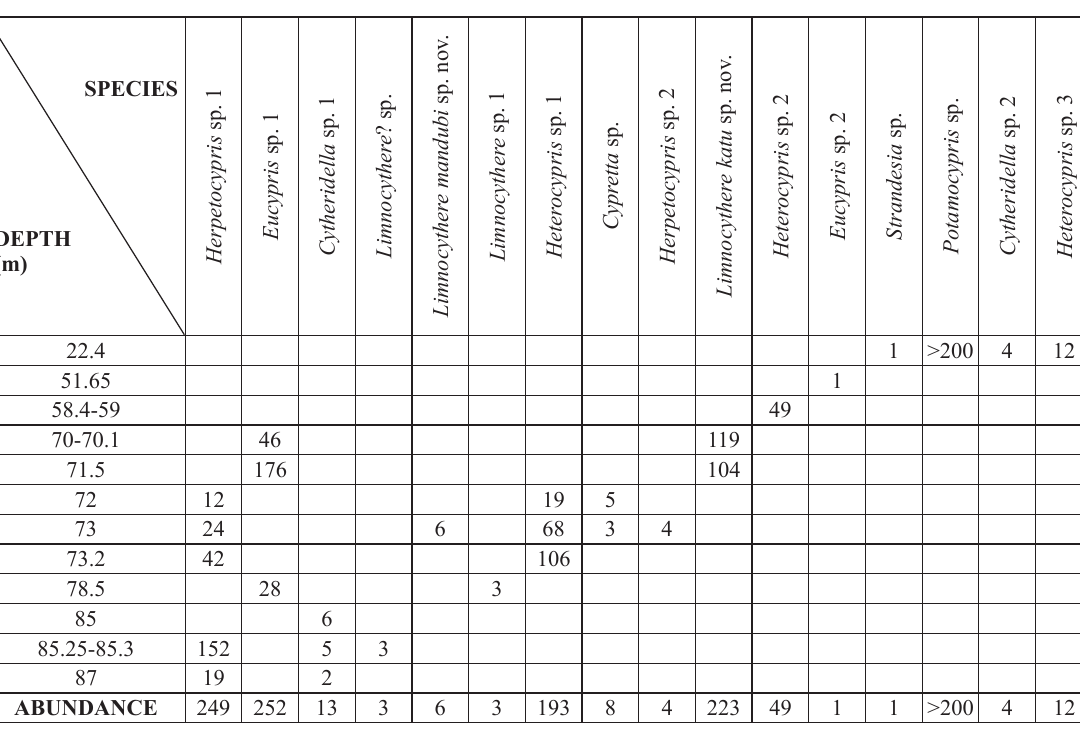
Occurrence and abundance of the taxa studied along the